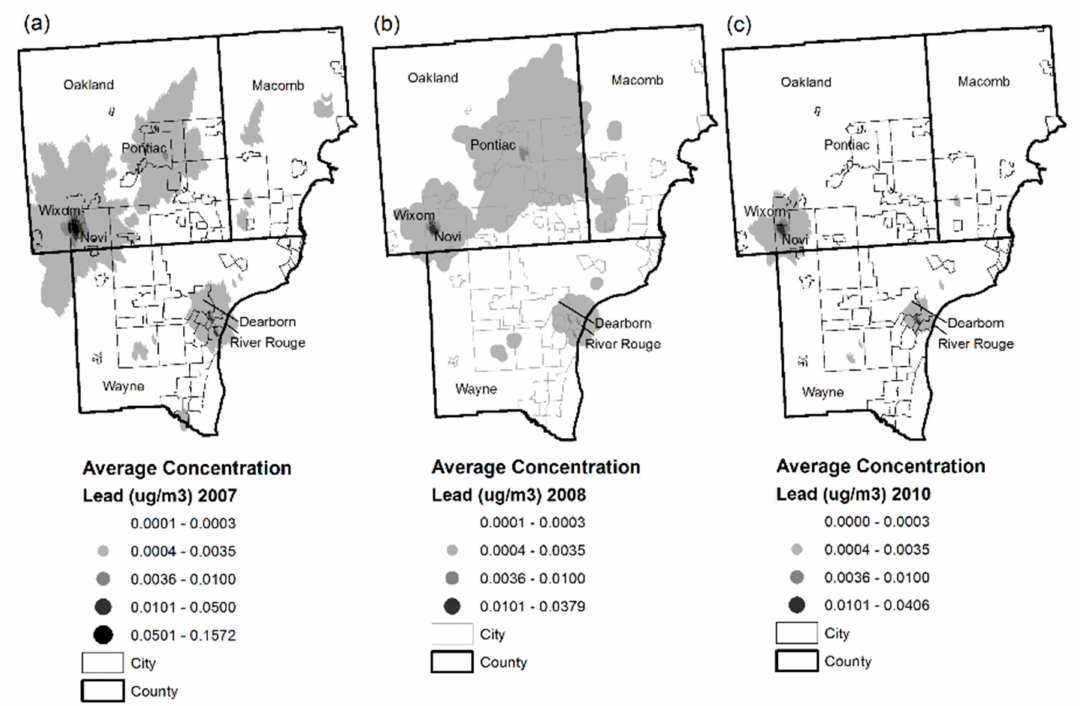
Figure 6. Three highest airborne lead concentration years (2007, 2008, 2010) over the study period in the Detroit Metropolitan Area. ( a ) average concentration lead in 2007; ( b ) average concentration lead in 2008; ( c ) average concentration lead in